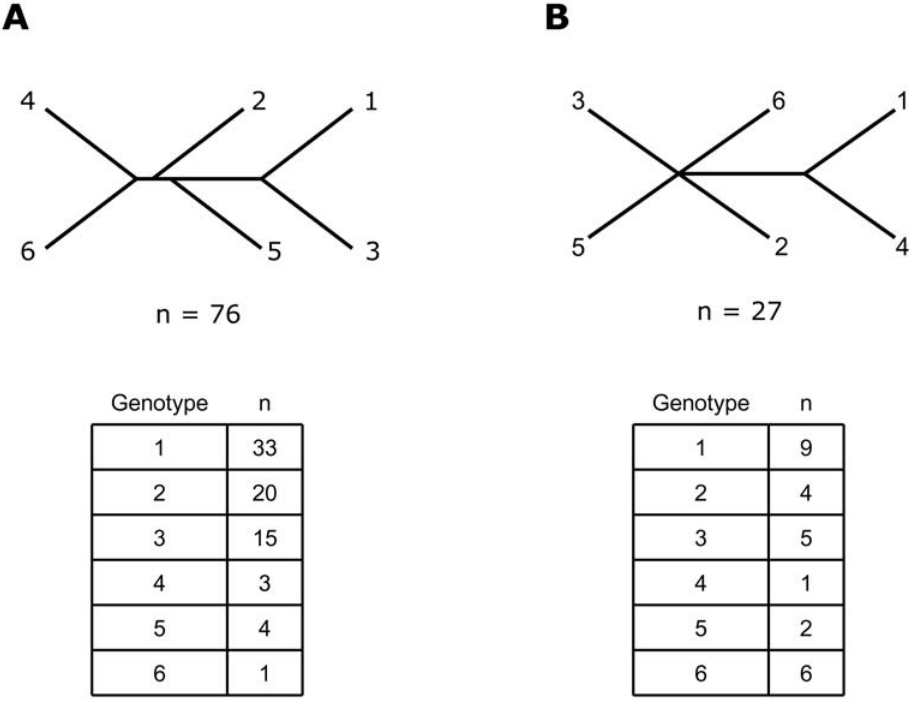
Figure 1. Unrooted HCV Cladograms From Previous Studies. Panel A shows the first cladogram to divide HCV into six genotypes, based on a neighbor-joining analysis of the NS5 region of HCV that included 76 sequences (Simmonds et al. 1993). Panel B shows a more recent HCV consensus tree with a different genotype branching pattern compared to Panel A, based on an analysis of 27 full-length HCV genomic sequences (Salemi et al. 2002). The table below each panel indicates the genotype distribution of the sequences analyzed in these studies.